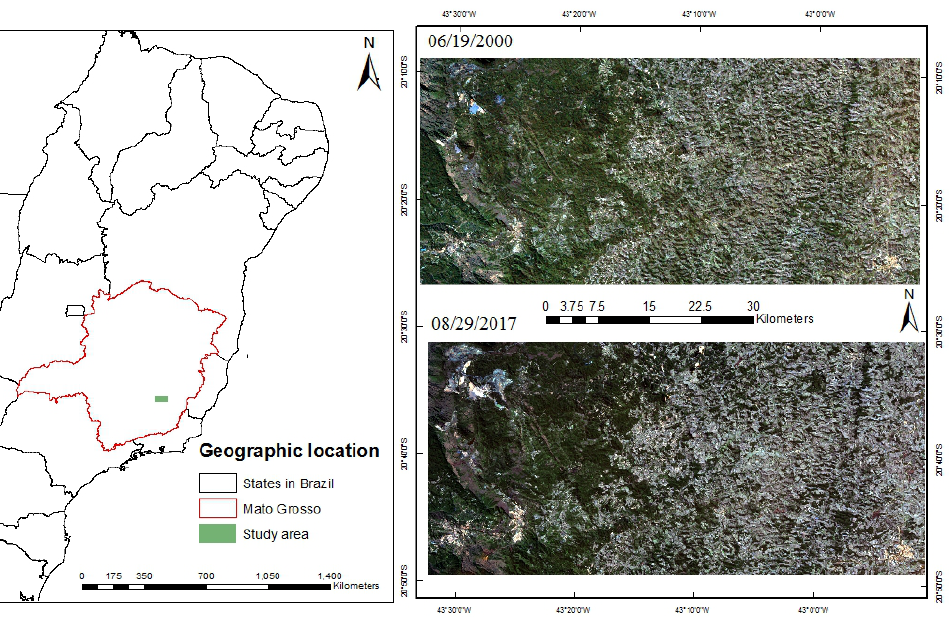
Figure 1. Geographic location of the disaster area and Landsat images at 19 June 2000 and 29 August